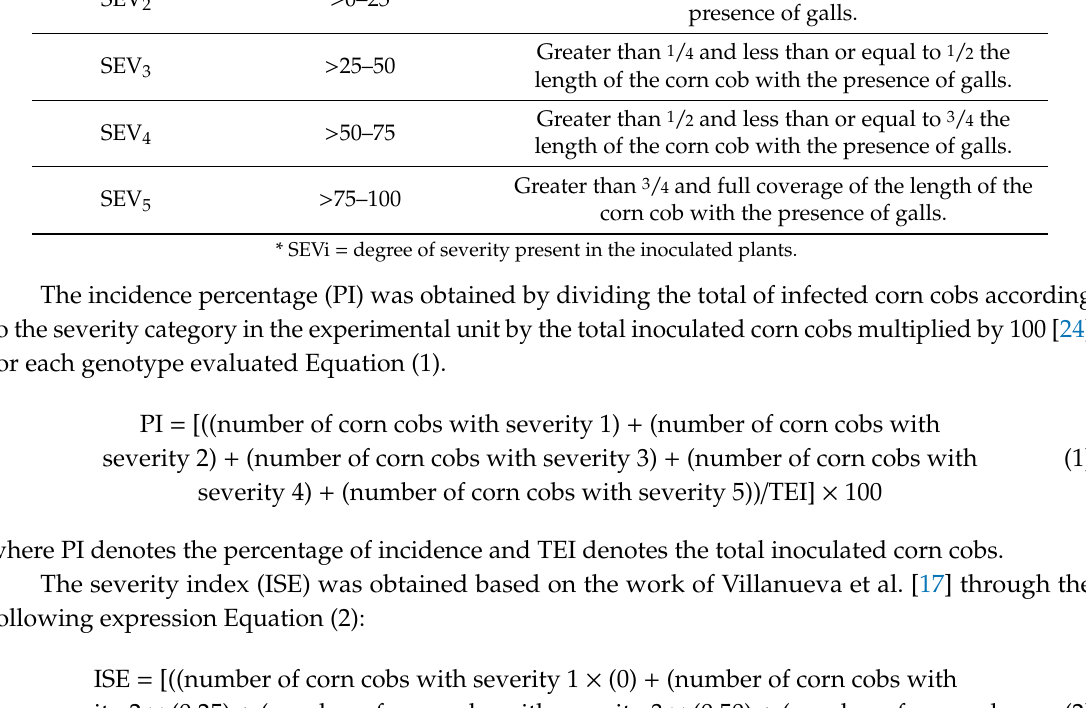
Table 1. Severity of infection by the MA-Um1 strain according to the percentage of coverage present on the corn cob. Cob Cover by Galls (%) Judgment of Categorization No presence of galls. Less than or equal to 1 / 4 length of corn cob with the presence of galls. Greater than 1 / 4 and less than or equal to 1 / 2